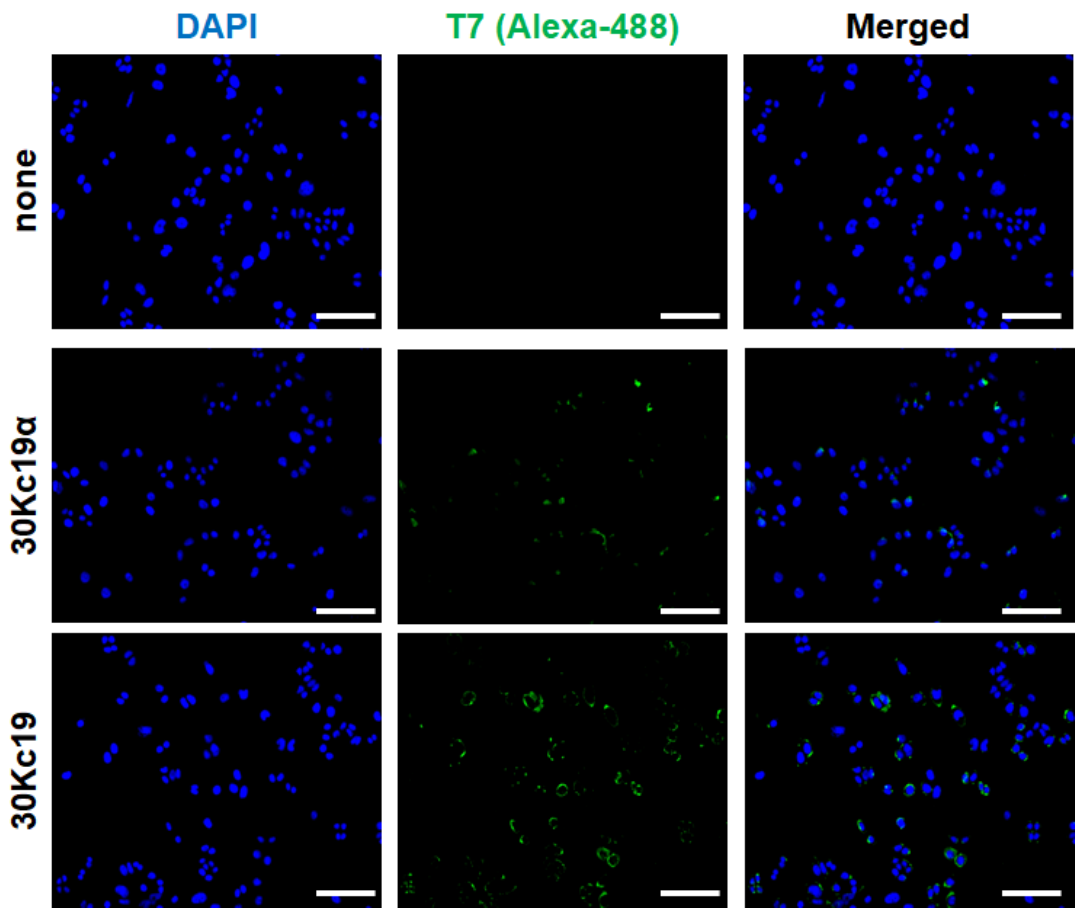
Figure 2. Intracellular delivery of recombinant 30Kc19α protein into EPO–CHO cells. EPO–CHO cells were treated with 16 μM 30Kc19α for 4 h in a complete medium. Intracellularly delivered 30Kc19α was then visualized by immunofluorescence analysis using anti-T7 tag primary antibody and Alexa Fluor 488-conjugated secondary antibody (green). The cell- penetrating property of 30Kc19α was compared to that of full-length 30Kc19. Cell nucleus was stained by DAPI (blue). Scale bar, 100 μm.